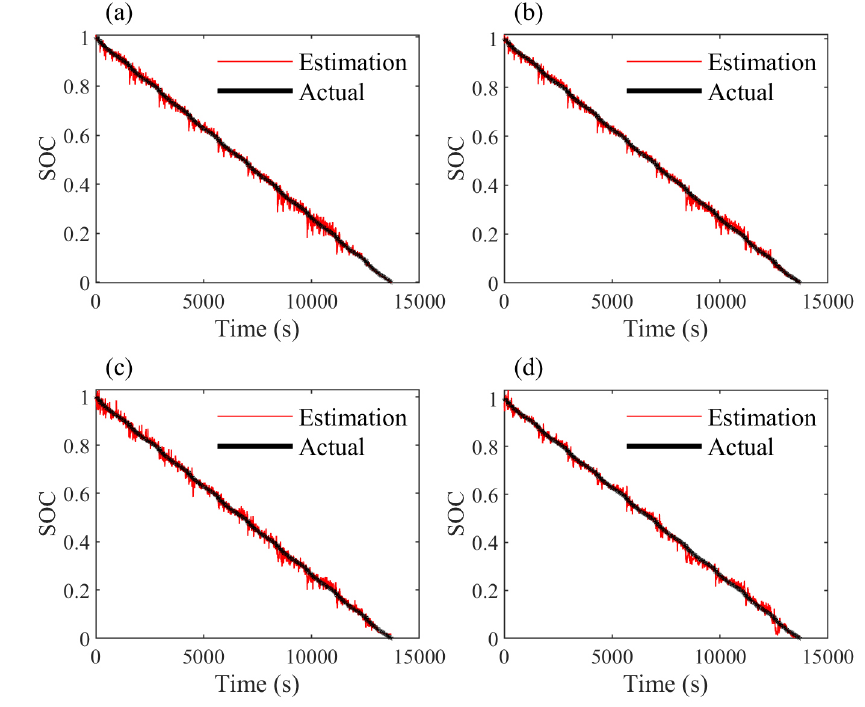
Figure 15. SOC estimation results correct. for the UDDS profile in the four modes (using RBF): ( a ) first mode, ( b ) second mode, ( c ) third mode, and ( d ) fourth mode.